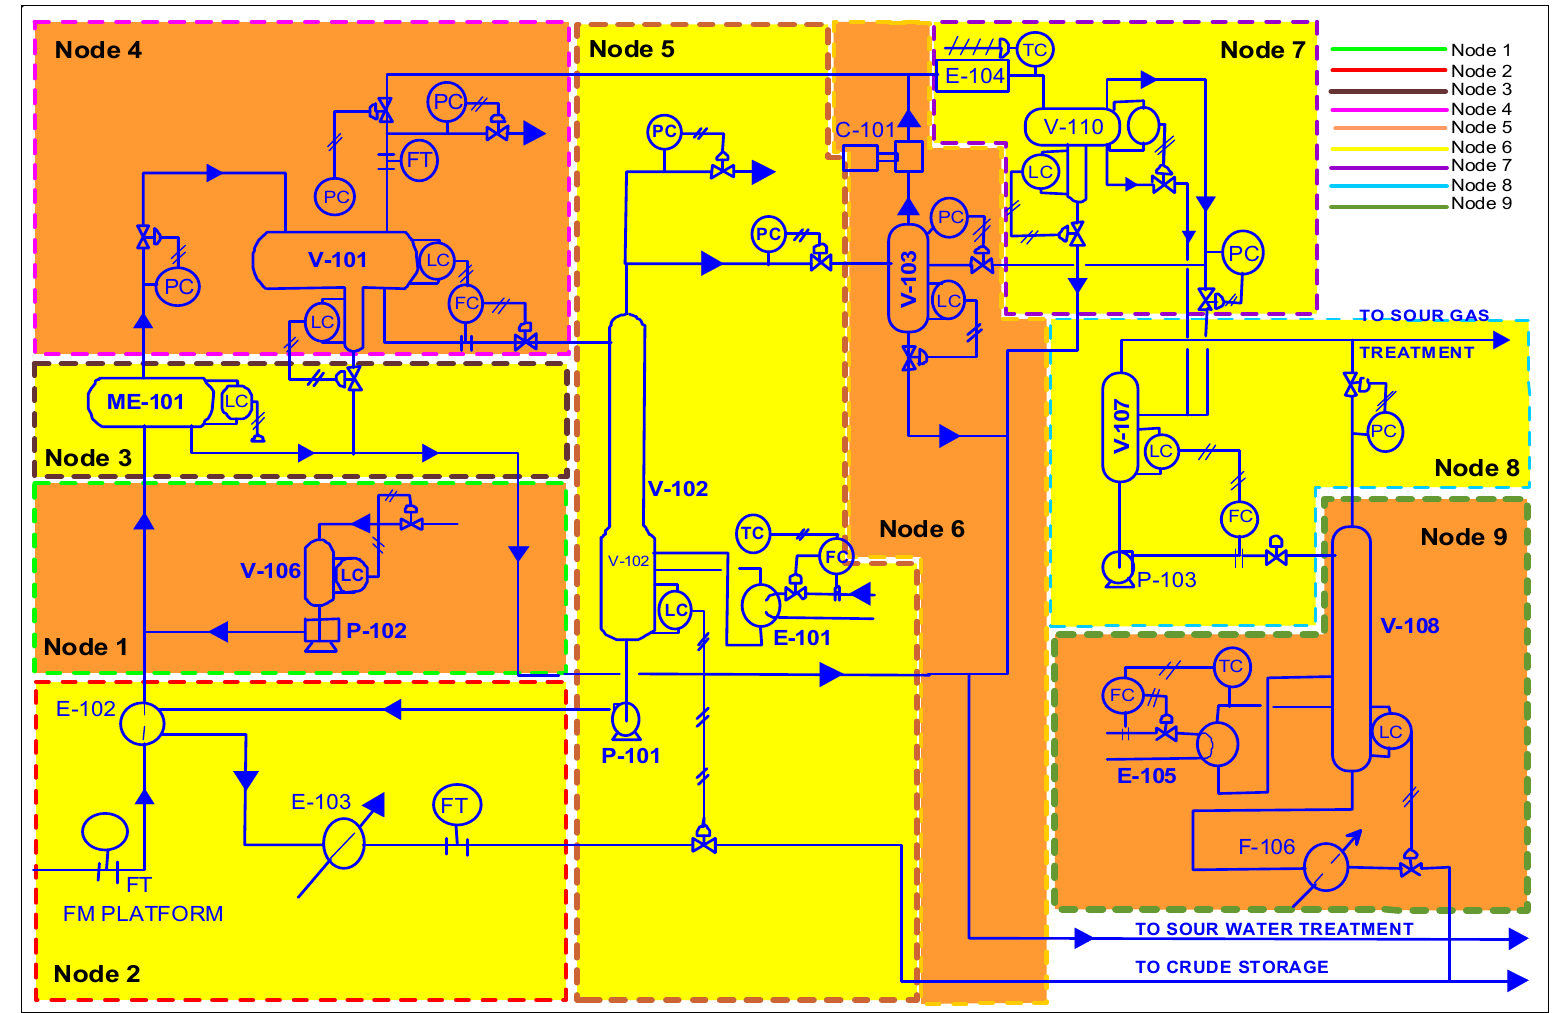
Figure 7. Safety-color mapping by the application of the cooperative HAZOP-DMRA-SCM method at the workplaces of a SCOPI, taking into consideration for each node the most frequent colors.